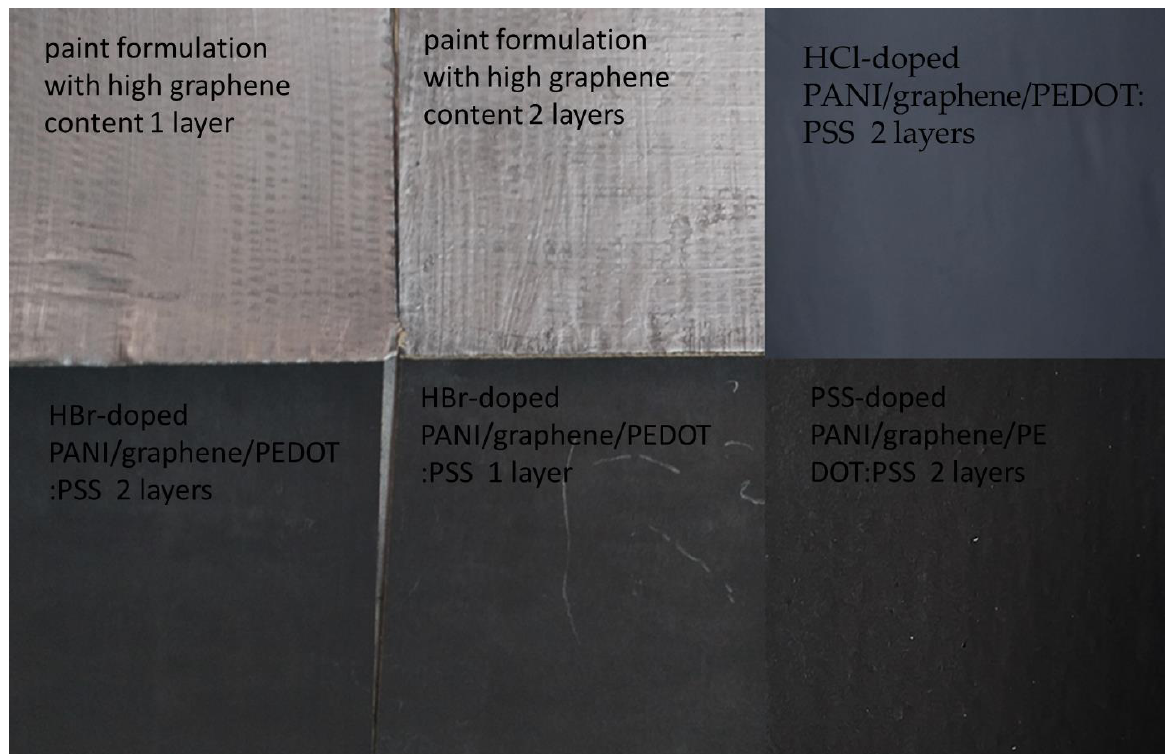
Figure 4. Examples of good-quality coatings onto large (16 × 16 cm 2 ) paper boards used for EMI- shielding properties characterization.